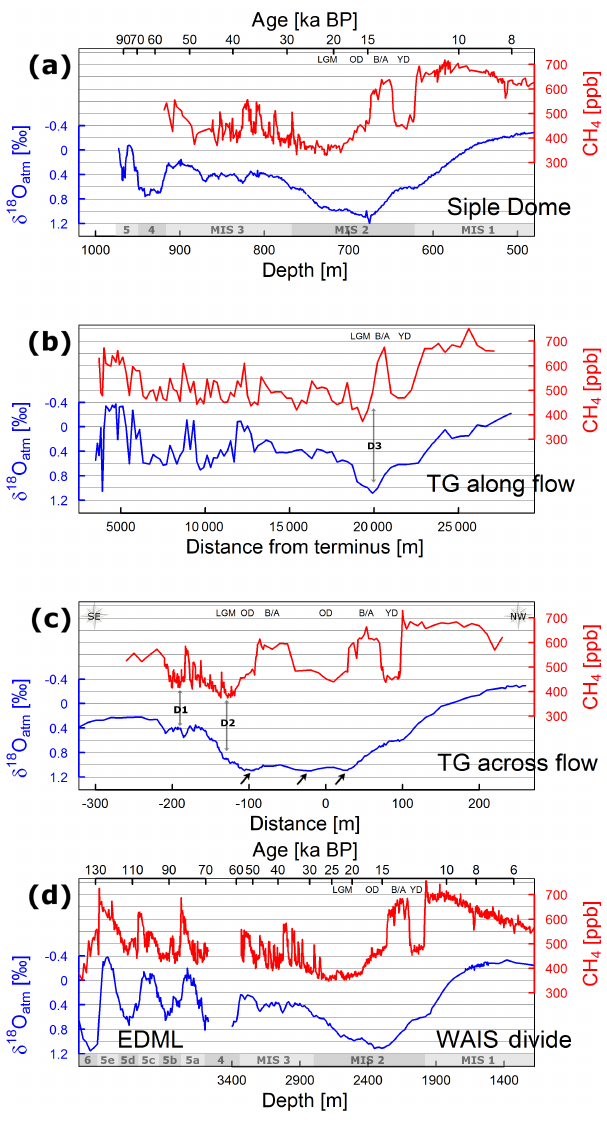
Figure 3. δ 18 O atm (blue; note reversed scale) and methane (red) records from deep ice cores (Siple Dome: Brook et al., 2005; Sev- eringhaus et al., 2009; WD: Buizert et al., 2015; EDML: Capron et al., 2010; Schilt et al., 2010) and from Taylor Glacier (across- flow, along-flow). TG along-flow methane data are based on lab analyses only, whereas the across-flow data are a combination of lab and field analyses. For TG across-flow, the 0m point is arbi- trarily chosen at a conspicuous circular feature (Fig. 5a), and the threefold δ 18 O atm maximum is highlighted with arrows. The ap- proximate locations of the three deep cores D1, D2, and D3 are shown in (b) and (c) . The intersection point of the two TG sampling lines is at − 240m on the across-flow scale, and at 13.5km on the along-flow scale. Distinct climate periods of the deglaciation (top of each panel) and marine isotope stages (MIS, bottom) are